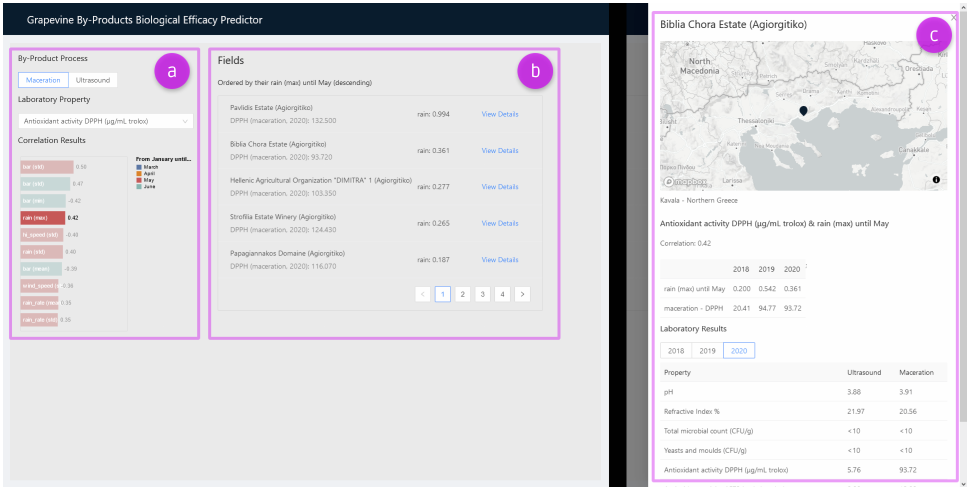
Figure 9. Interface for the analysis of biological efficacy in by-products: ( a ) by-product extraction method and correlation visualisation; ( b ) candidate fields ordered by rain fall; ( c ) detailed data of a field selected in ( b